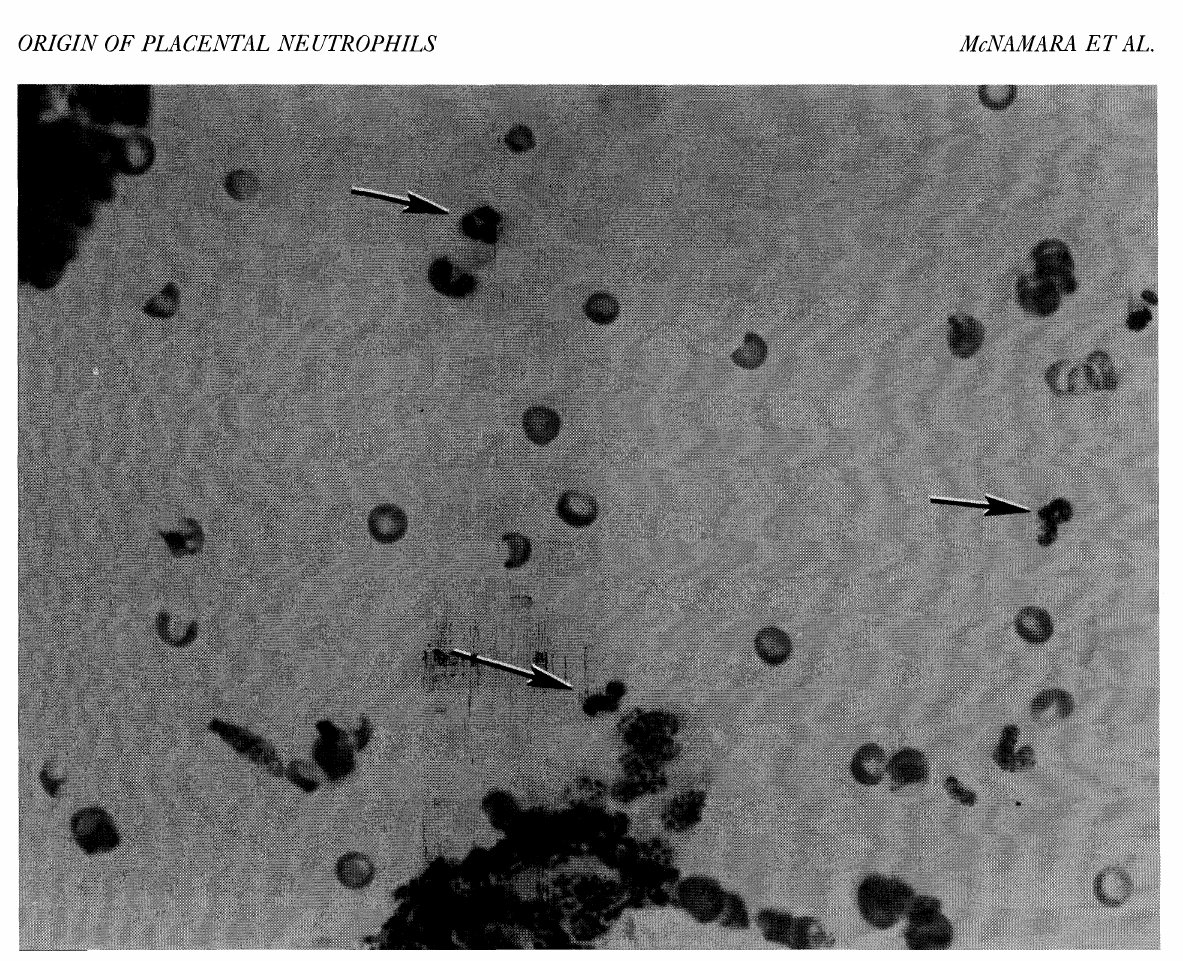
Fig. 2. H&E staining of cytospin specimen, arrows identifying PMNs.